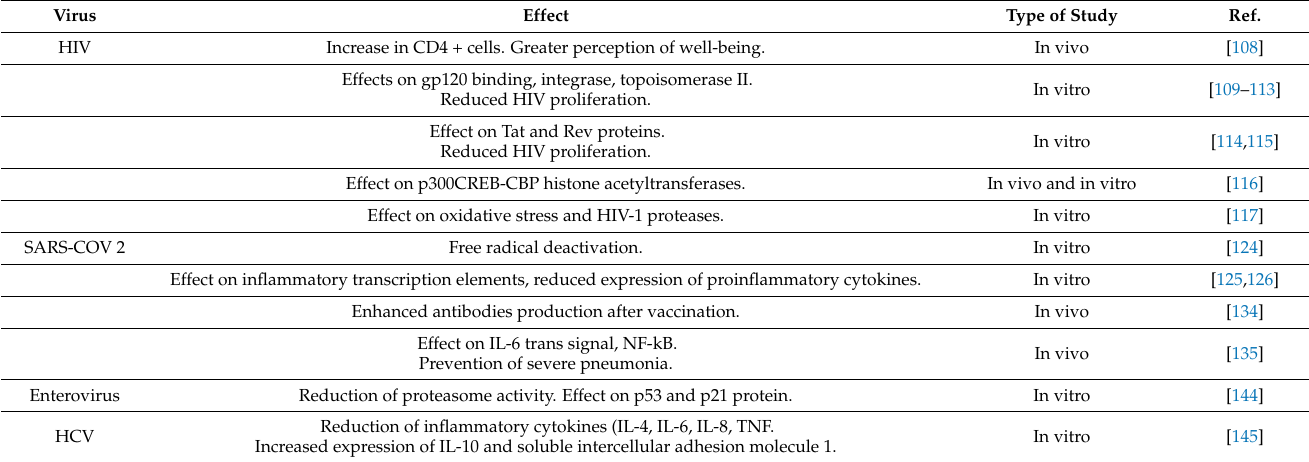
Table 1. Modification of the immune response induced by curcumin towards viral